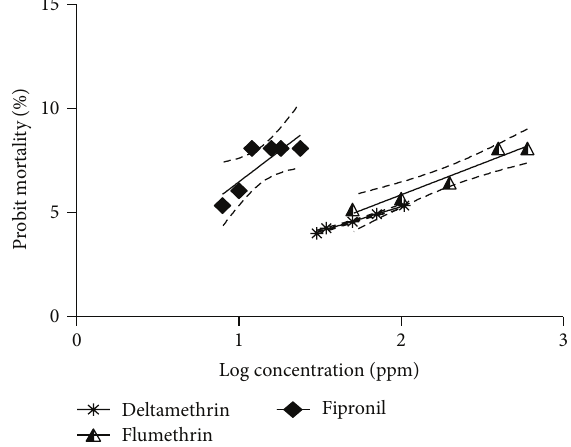
Figure2:Comparativeprobitmortalityinlarvaeof R.(B.)microplus subjectedtodoseresponseLPTassaywithdeltamethrin,flumethrin, and